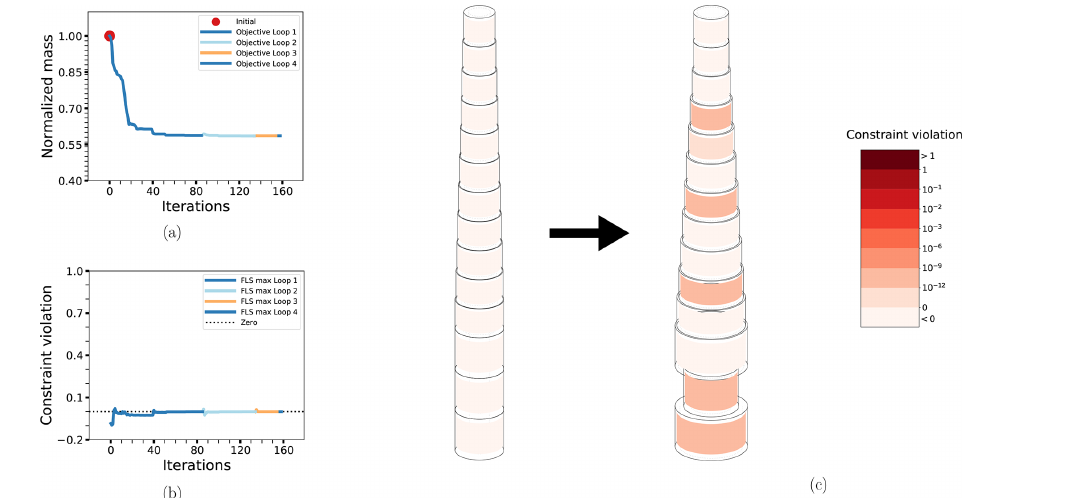
Figure 15. The optimization process for case OC3-PF: the objective function (a) , maximum non-linear constraint violations (b) and the change in the design from initial to final configuration (c) . Details as in previous